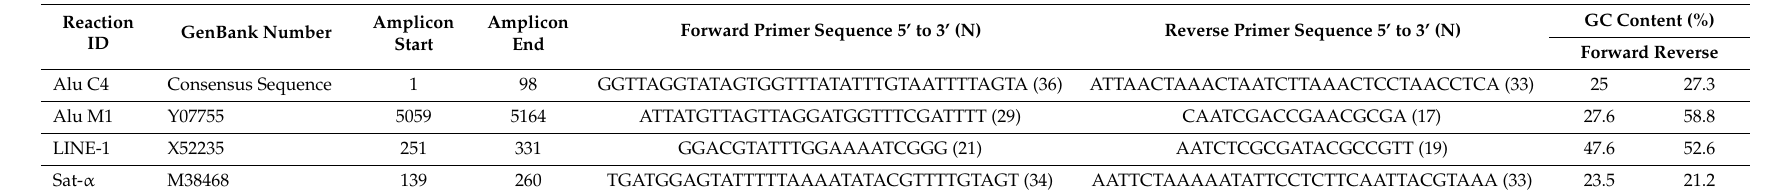
Table 2. Primers